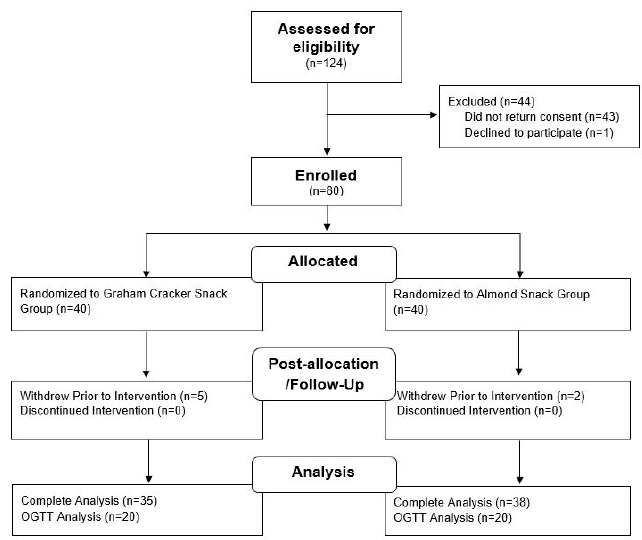
Figure 1. Participant flow throughout the randomized, controlled parallel-arm study. OGTT, oral glucose tolerance test.